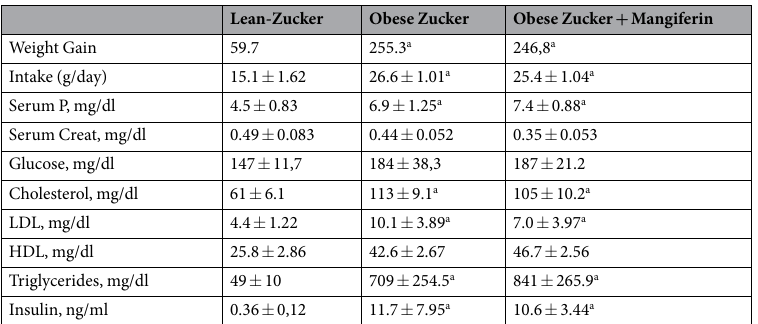
Table 7. Metabolic Syndrome and renal parameters in Obese rats treated or not with antioxidant. a Significant differences at least p < 0.05 vs Lean